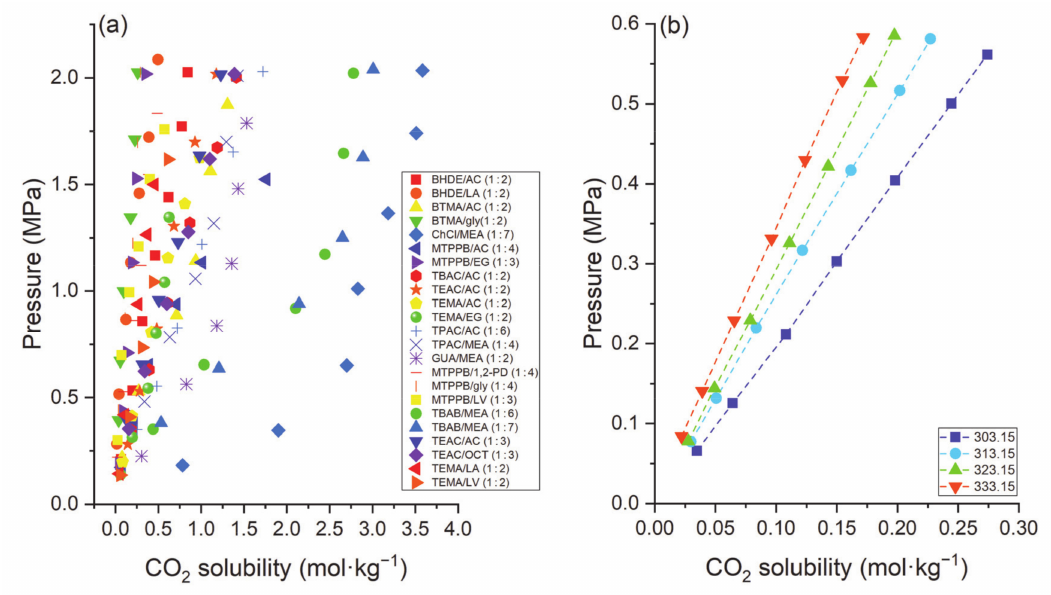
Figure 5. Effect of pressure on ( a ) various DESs at 298.15 K, and ( b ) TEAC/LV (1:3) DES at different temperatures. Data are extracted from